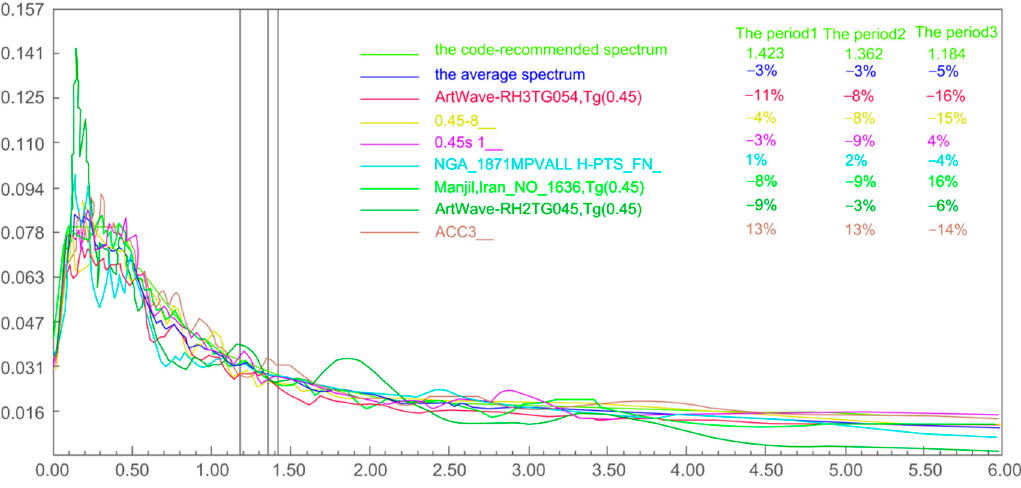
Figure 5. Spectra of the seismic influence coefficients of the seven ground-motion waves. Table 10. Variations in the period ratios of the seven ground-motion waves.